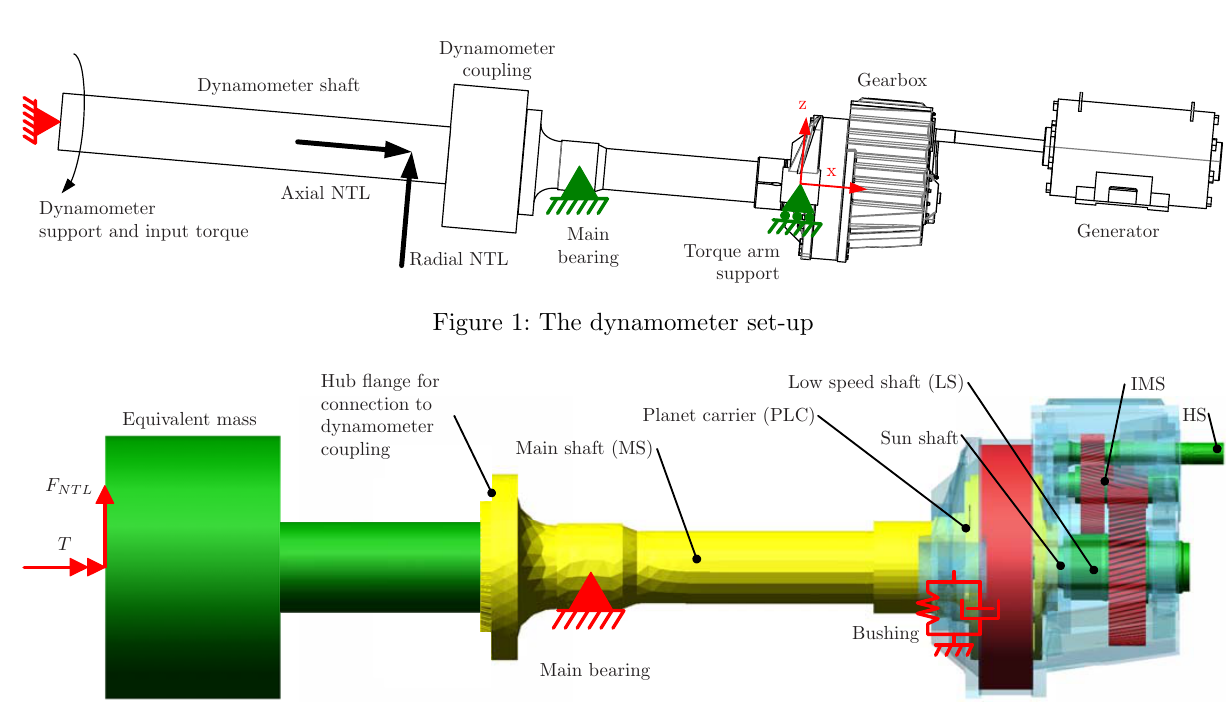
Figure 2: Main components of main shaft and gearbox